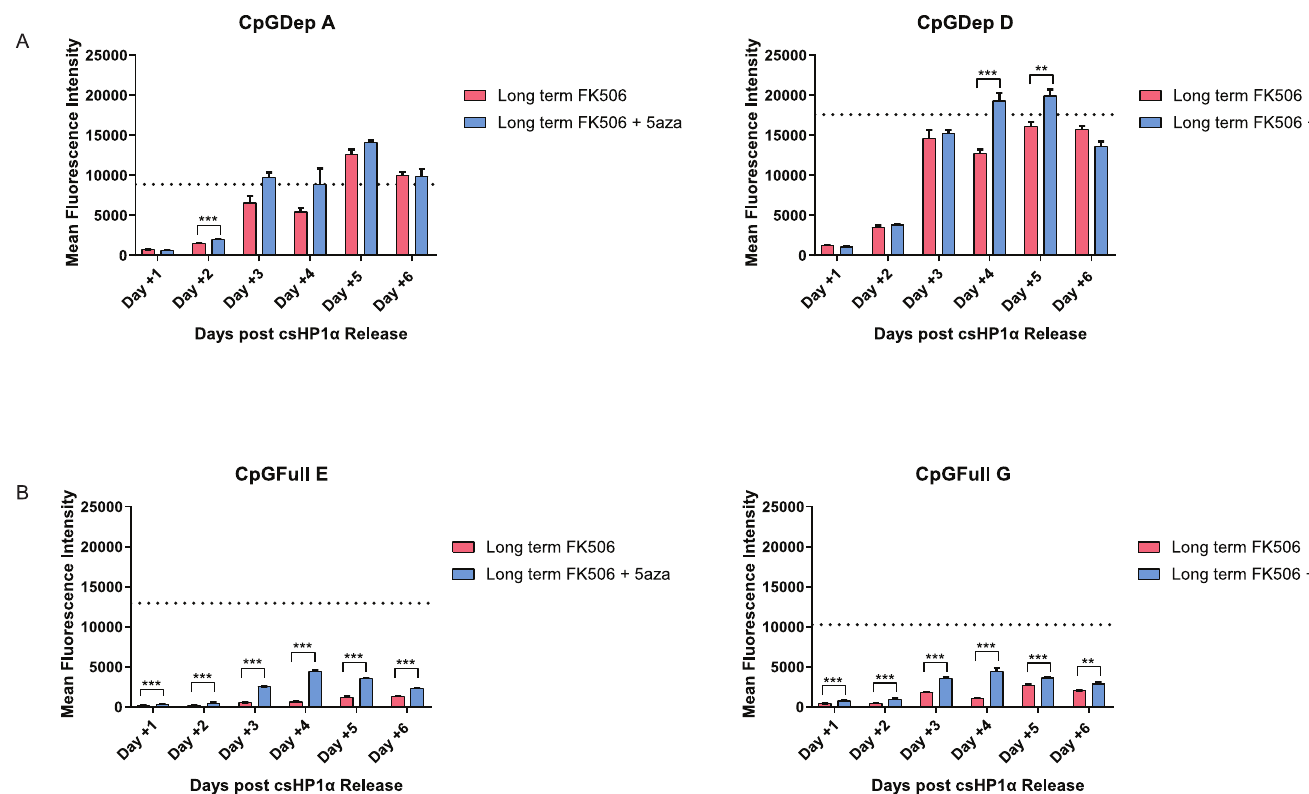
Fig 6. Recovery of gene expression after long-term heterochromatization. A) Re-expression of the CpGDep A and CpGDep D cell lines after five weeks of csHP1 α - induced silencing, with or without the addition of 5-aza. B) Re-expression of the CpGFull E and CpGFull G cell lines after five weeks of csHP1 α -induced silencing, with or without the addition of 5-aza. Dotted line represents baseline expression for each cell line. Flow cytometry was performed in biological triplicate on Attune 1. n = 3, �� P � 0.01. ��� P � 0.001.